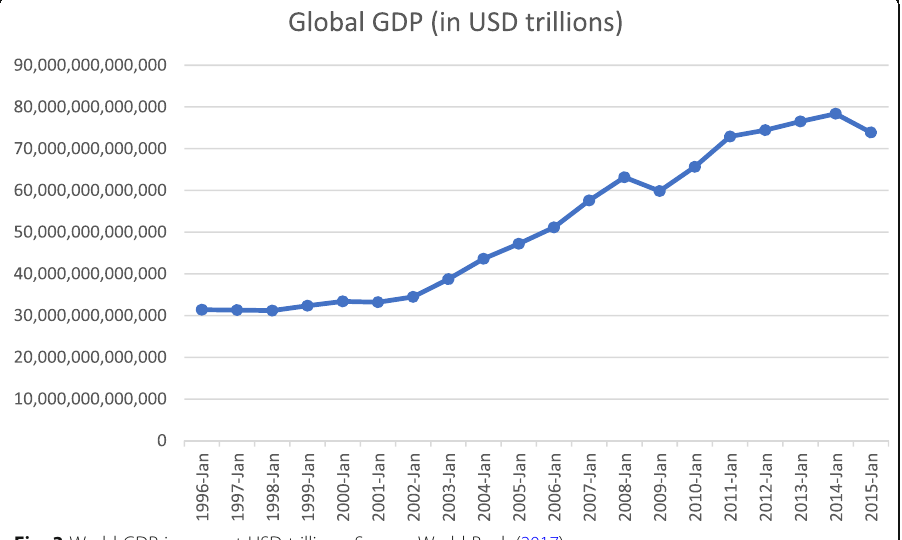
Fig. 3 World GDP in current USD trillions. Source: World Bank (2017)